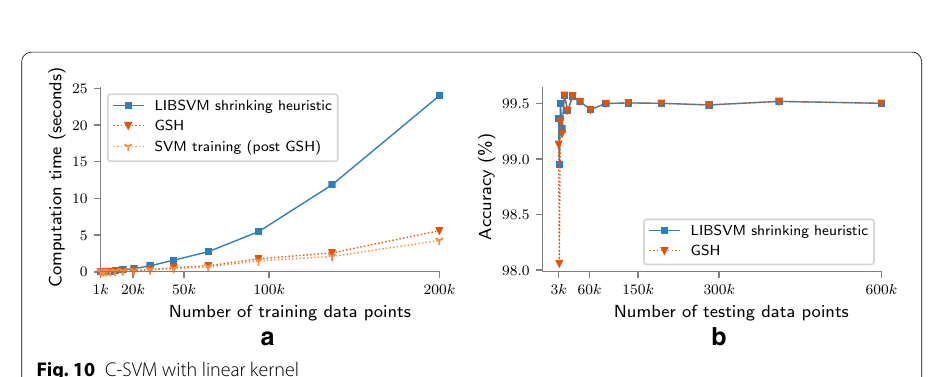
Fig. 10 C-SVM with linear